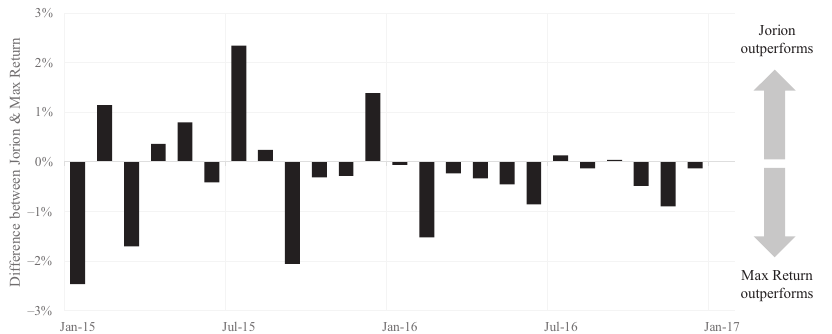
Figure 5. Monthly return difference between JB and MR portfolios, Test 1, low volatility